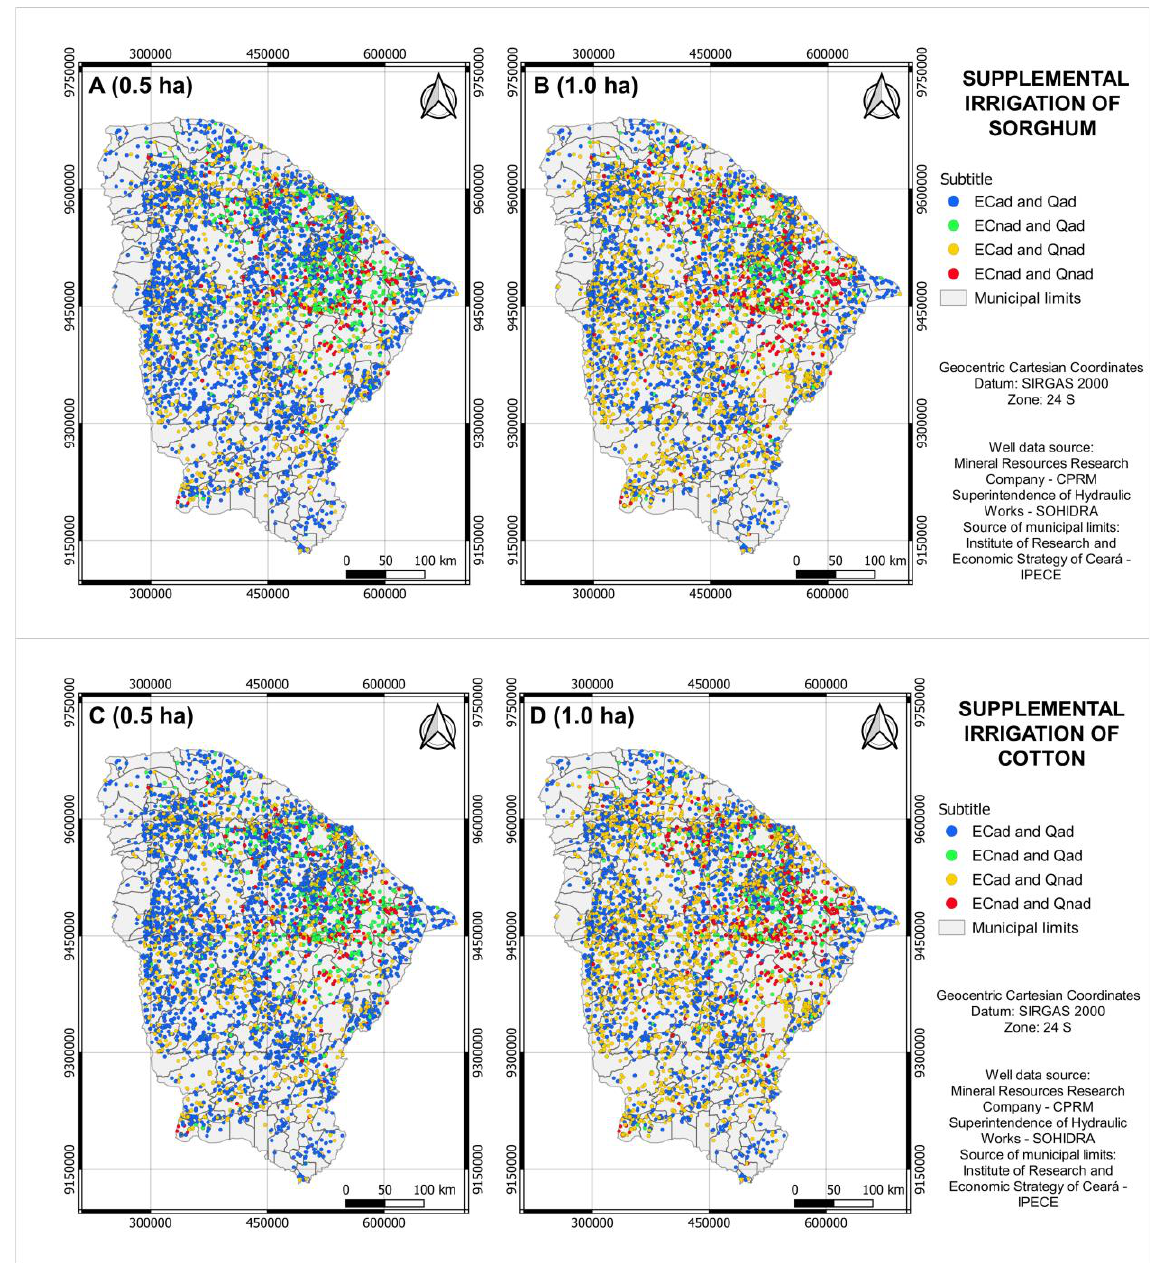
Figure 4. Potential of brackish groundwater in the State of Ceará (Northeast Brazil) for supplemental irrigation of sorghum in 0.5 ha ( A ) and 1.0 ha ( B ), and supplementary irrigation of cotton in 0.5 ha ( C ) and 1.0 ha ( D ), based on the threshold electrical conductivity of the irrigation water (EC) and discharge rate (Q). EC ad : adequate electrical conductivity; EC nad : inadequate electrical conductivity; Q ad : adequate discharge; Q nad : inadequate discharge.